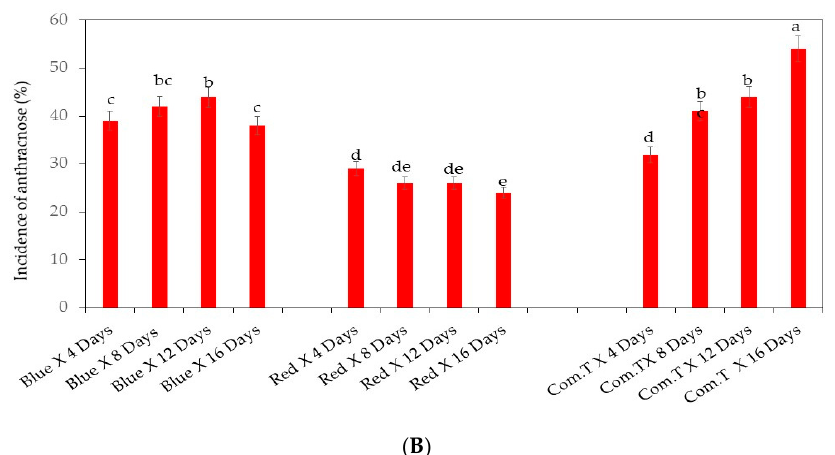
Figure 1. ( A ) Influence of light-emitting diode (LED) light exposure on inoculated avocado cultivar Fuerte. ( B ) Influence of LED light exposure on inoculated avocado cultivar Hass. The exposure of the fruit to blue or red LED light was for 6 h per day during storage. Ten replicate tray packs, each containing four fruit, underwent di ff erent postharvest treatments. Mean values of bars marked by di ff erent letters were significantly di ff erent at p < 0.05, according to Fisher’s protected LSD test. Blue, blue LED light; Red, red LED light; Com.T, commercial treatment.